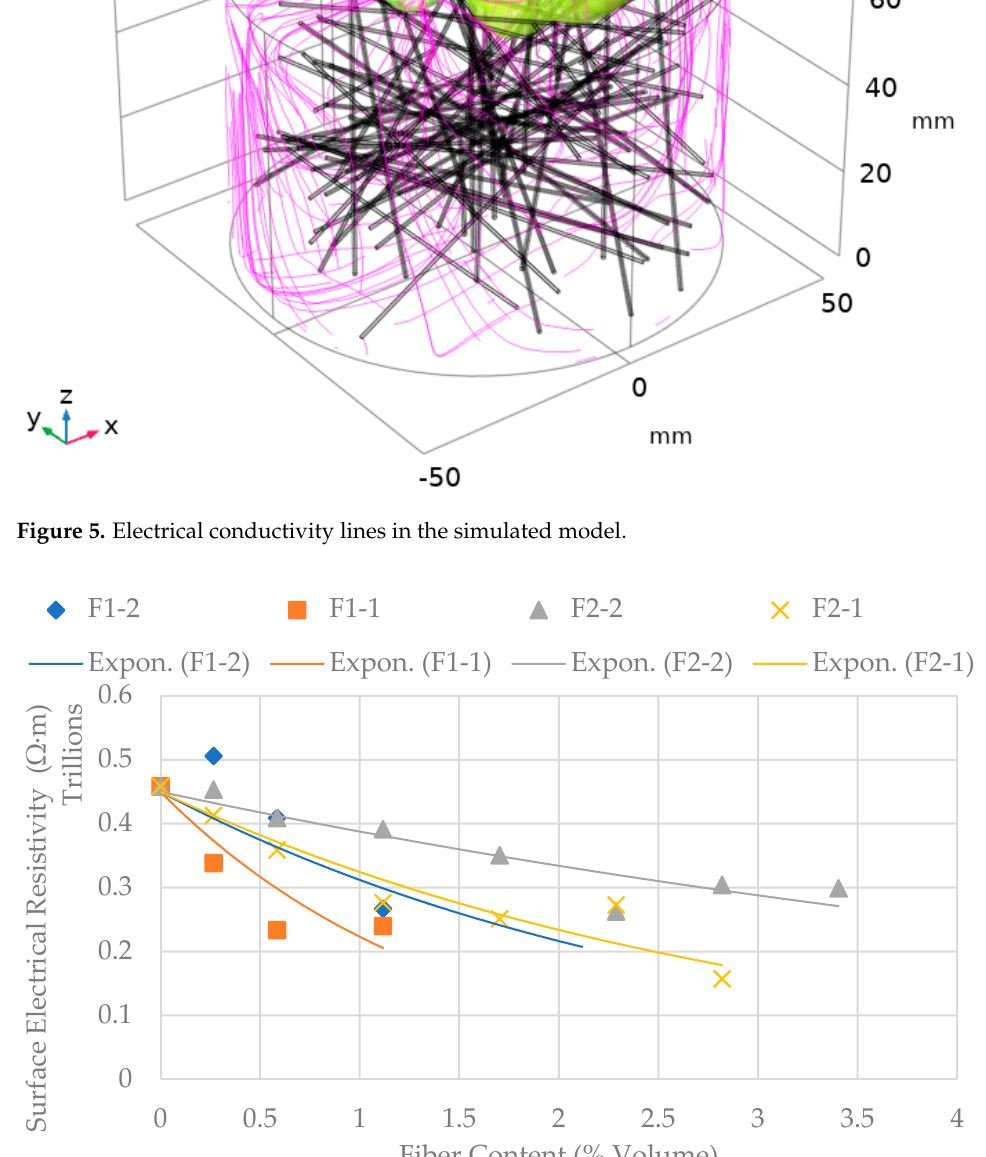
Figure 6. The electrical resistance for different percentages of fiber content. Table 3. Regression results for surface electrical resistivity. Model